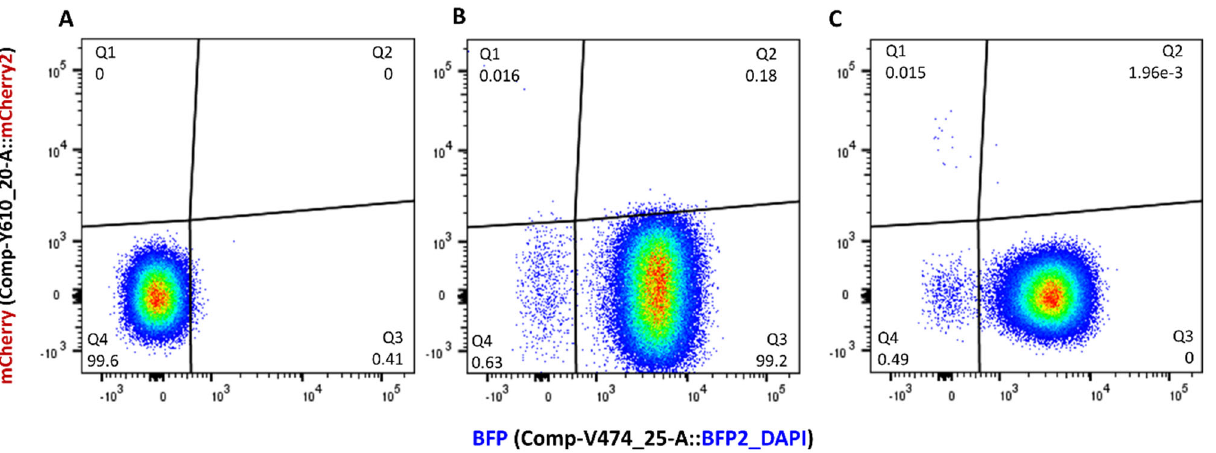
Figure 2. Blue fluorescent protein gene ‐ tagging of low ‐ copy ‐ number IncM plasmid pJIMK46 via homologous recombineering. ( A ) The tra genes and mob genes of the conjugation machinery of pJIMK46 are shown in red. The positions of the repA , repB and repC genes of IncM plasmids are indicated in brown. ( B ) To label pJIMK46 with a blue fluorescent protein gene ( ebfp2 ), the PCR prod ‐ uct containing the P C S ‐ ebfp2 ‐ bla construct and flanked by 40 bp overhangs (in yellow), which were homologous to the designated recombineering sites, was electroporated into a lambda ‐ red recom ‐ binase ‐ expressing E. coli host that also harbors pJIMK46 (Schematic not drawn to scale).